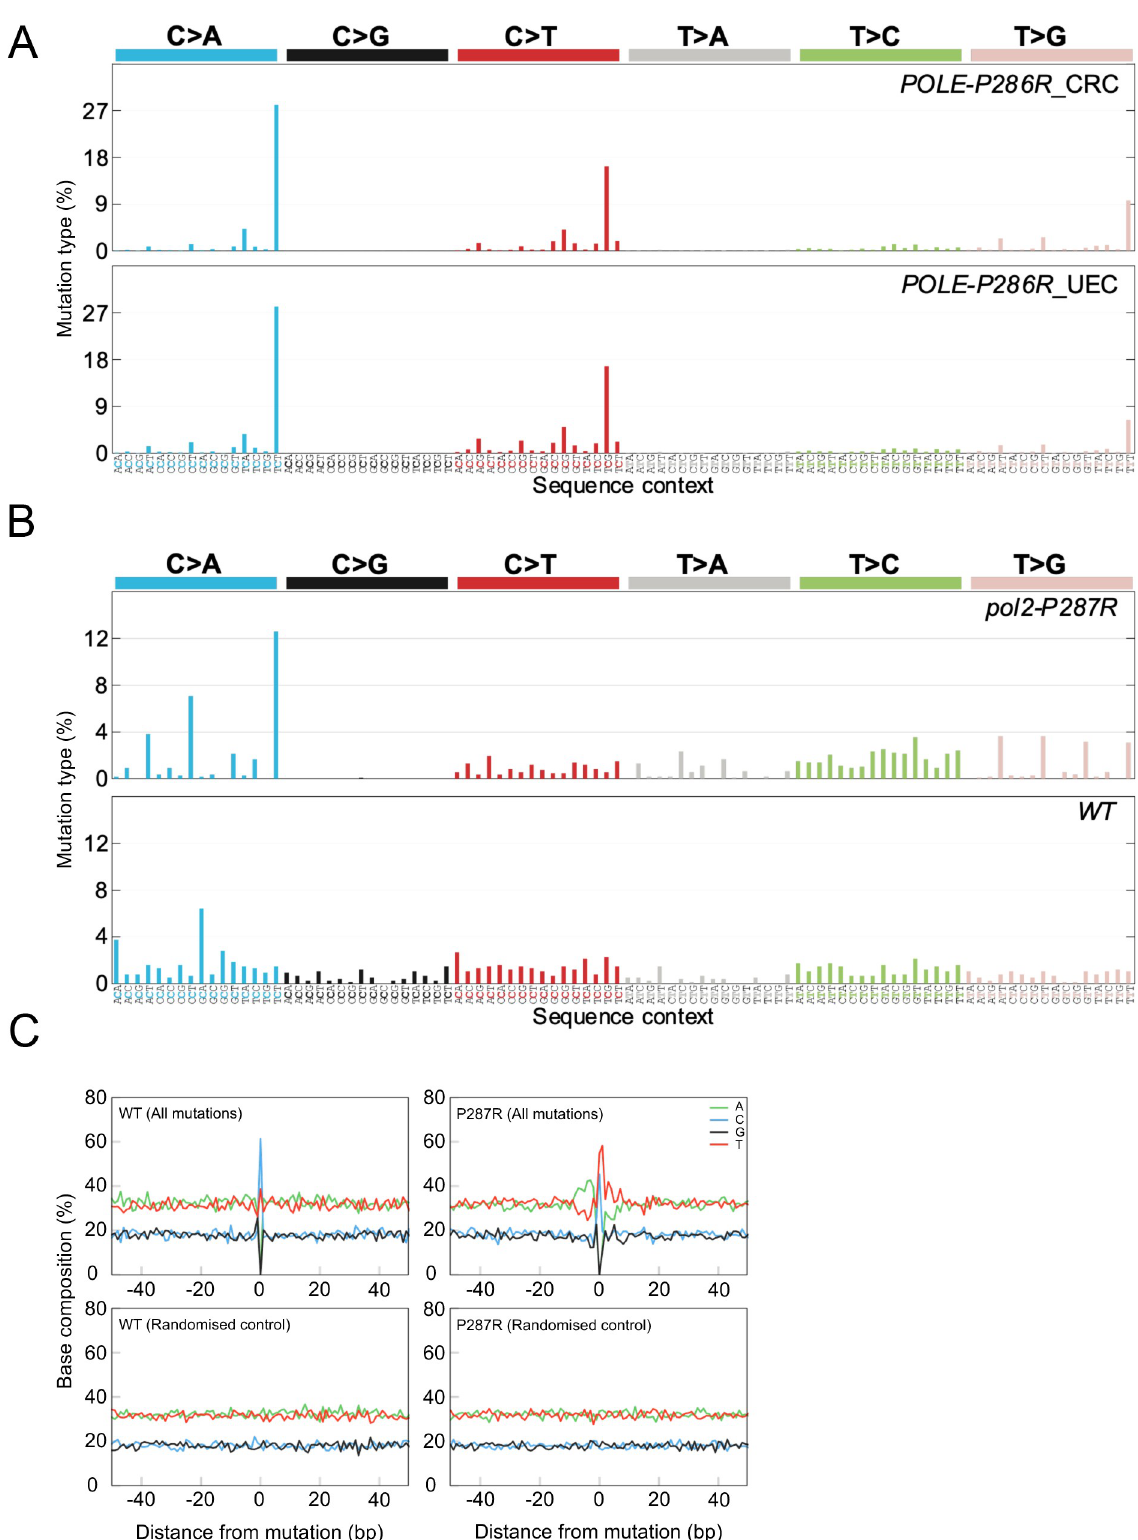
Fig 2. Mutational spectra of the P286R variant in human adenocarcinomas and S . pombe . (A) Mutation types in POLE-P286R colorectal carcinoma (top) and uterine endometrioid carcinoma (bottom). (B) Mutation types in pol2-P287R (top) and wild-type (bottom) [43] S . pombe . (C) Base composition in the vicinity of mutations in pol2-P287R and wild-type genomes.